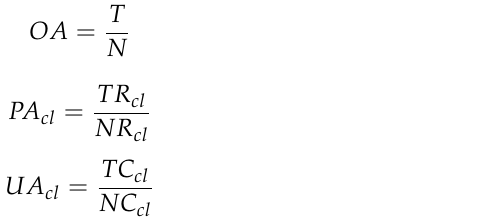
Figure 4. Temporal signature prototypes for the most common tree species in an area in central Europe (located in Czech